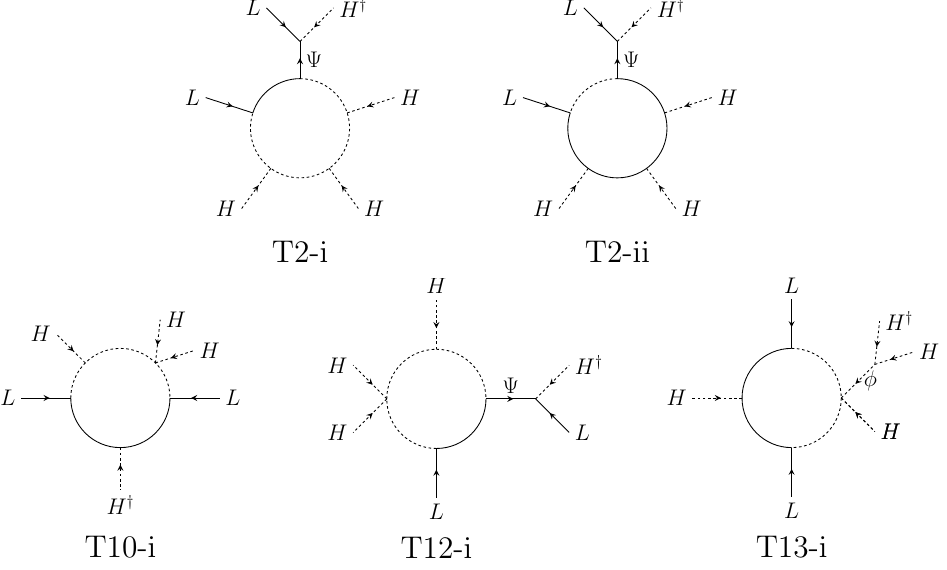
Figure 18 . Diagrams that can lead to a genuine d = 7 1-loop neutrino mass for which the largest representations of SU(2) L is at least a quadruplet. This group of diagrams require the quadruplet to be one of the particles inside the loop to avoid lower order contributions.